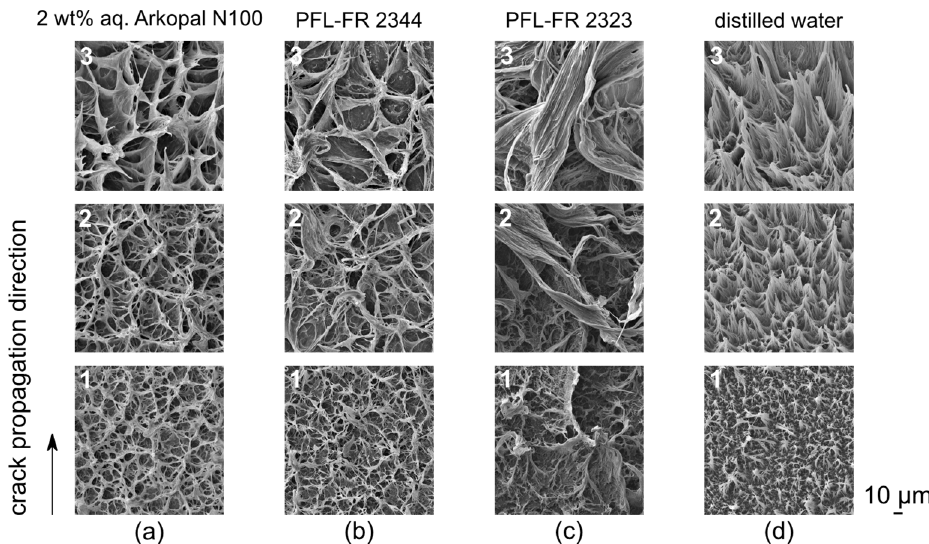
Figure 10. SEM detailed images of fracture surface microstructures depending on the environmental medium ( a – d ) and on crack length, respectively, the position 1, 2 and 3 (Figure 9) in crack growth direction on the overall fracture surface.